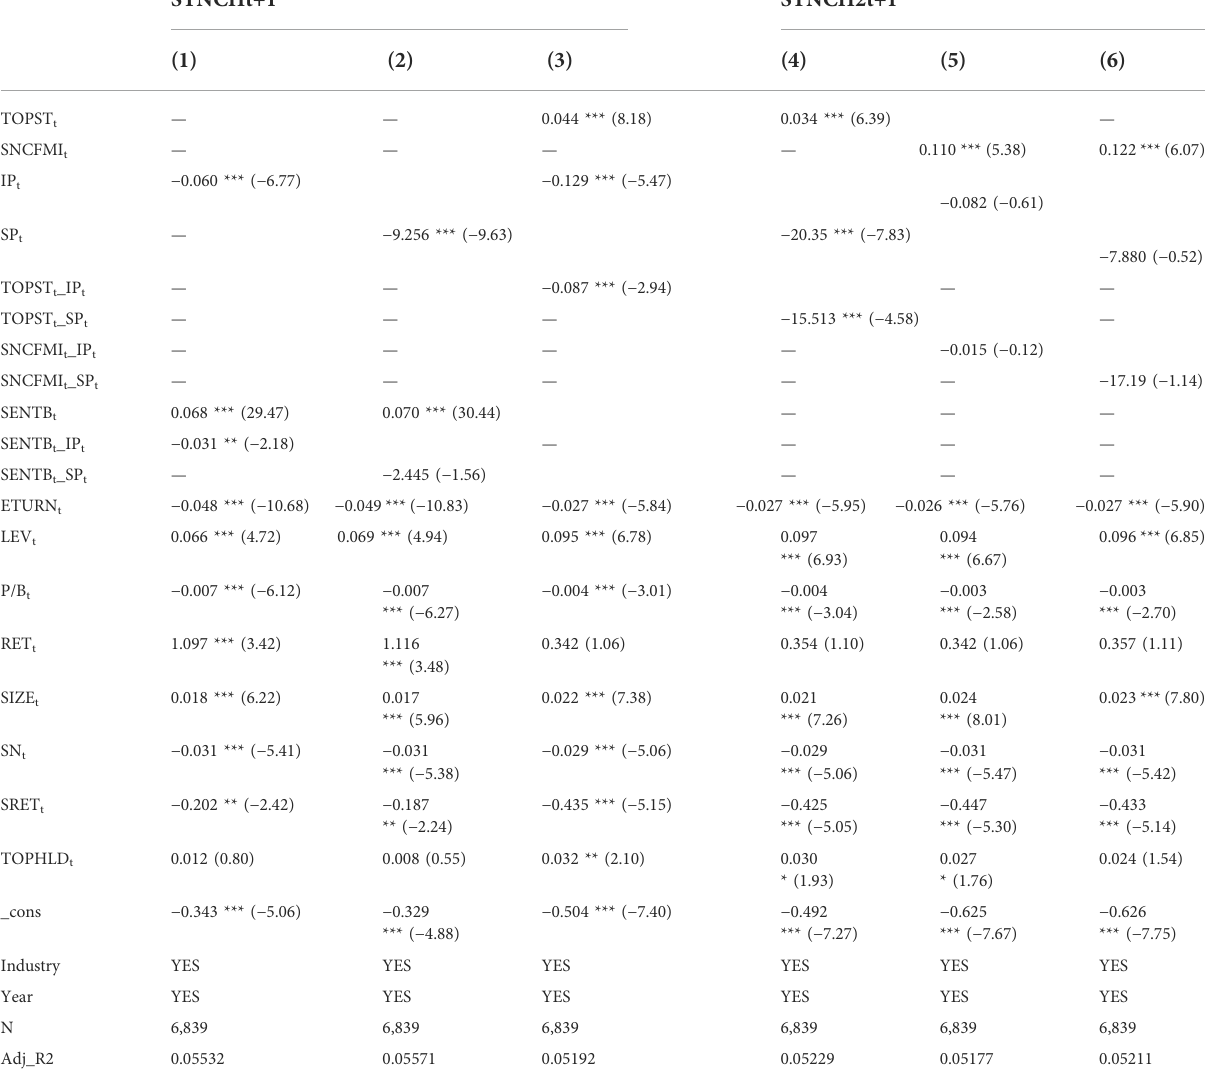
TABLE 4 Robustness